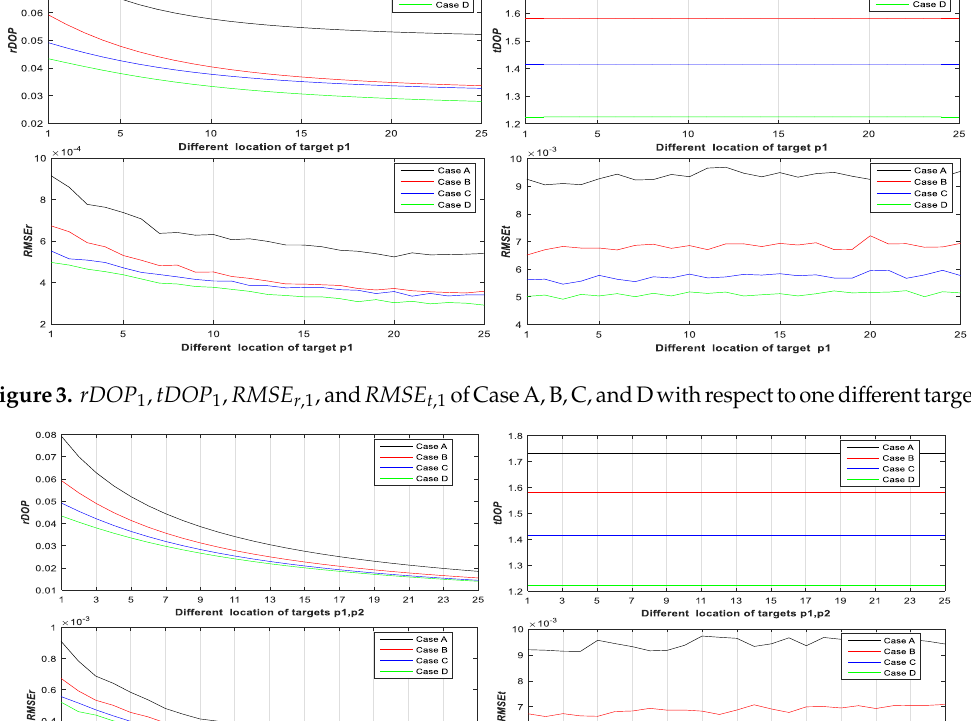
Figure 2. The target and scanner i + 1 geometry of experiment II.